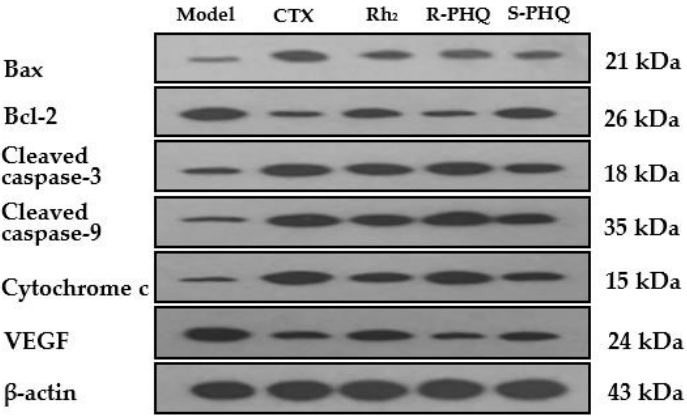
Figure 9. Effects of R-PHQ (20 mg/kg) and S-PHQ (20 mg/kg) on the protein expression of Bax, Bcl-2, caspase-3, caspase-9, cytochrome c, and VEGF were examined by Western blot (of three independent experiments performed).